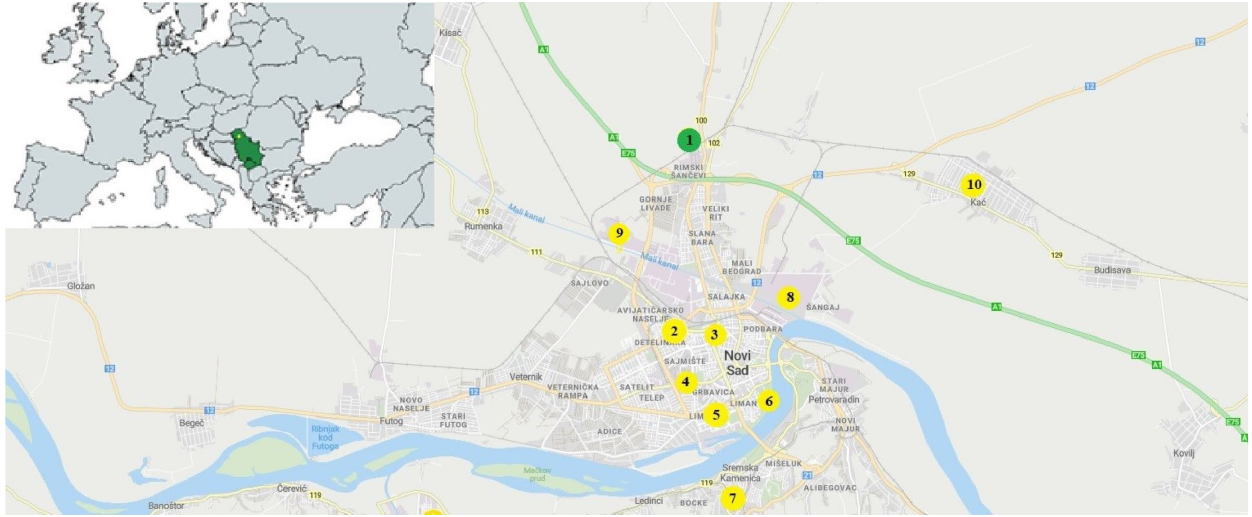
Figure 2. Network of stations for collecting data on meteorological factors and air pollution in the territory of Novi Sad: meteorological station: 1 (45°20 ′ N, 19°51 ′ E); air pollution stations: urban traffic–2 (45°15 ′ N, 19°49 ′ E), 3 (45°25 ′ N, 19°83 ′ E), 4 (45°24 ′ N, 19°81 ′ E); urban background—5 (45°14 ′ N, 19°50 ′ E), 6 (45°25 ′ N, 19°85 ′ E); suburban background—7 (45°13 ′ N, 19°50 ′ E); suburban industrial—8 (45°16 ′ N, 19°52 ′ E), 9 (45°29 ′ N, 19°78 ′ E); suburban traffic—10 (45°17 ′ N, 19°56 ′ E).